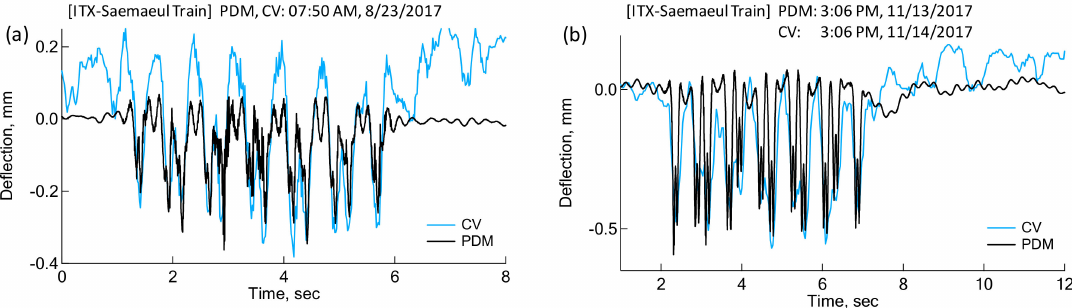
Figure 11. Deflections evaluated by PDM and computer vision technique: ( a ) measured at the same time; ( b ) measured at a different day for the same